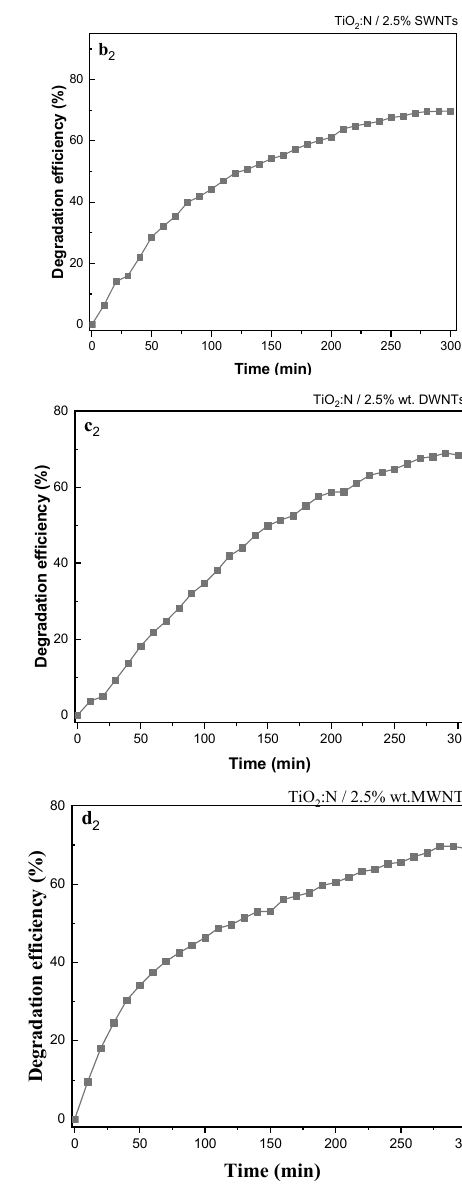
Figure 11. UV–VIS spectra of the RhB aqueous solutions containing T, S2, D, and M samples recorded by subsequence exposure to UV light time of 300 min ( a 1 , b 1 , c 1 , d 1 ); the dependence of the RhB degradation efficiency with the time of exposure to UV light in the presence of T, S2, D, and M samples ( a 2 , b 2 , c 2 , d 2 ).